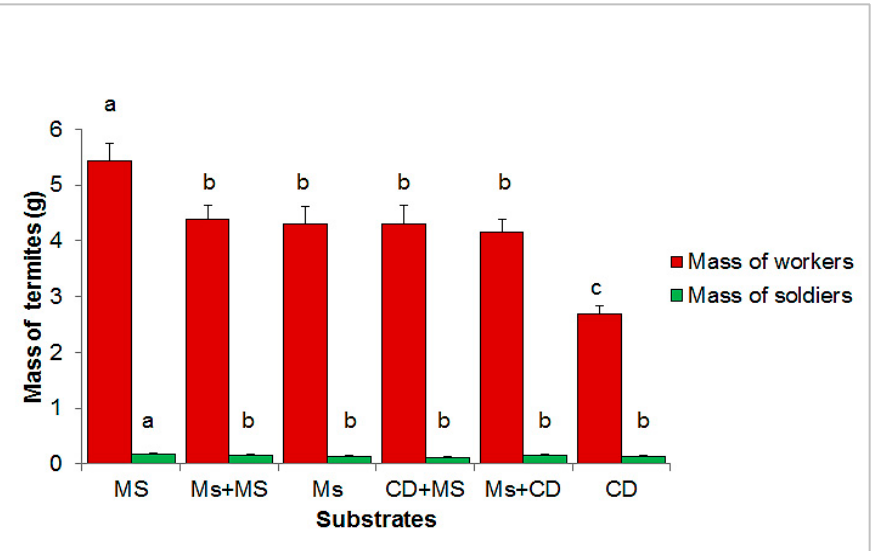
Figure 6. Average masses of soldiers and workers harvested per container according to substrates (MS = maize stems; Ms + Ms = maize cobs + maize stems; Ms = maize cobs; CD + MS = cow dung + maize stems; and Ms + CD = maize cobs + cow dung; CD = cow dung). Error bars represent standard errors. Histograms with the same letter are not significantly different at the 5% level. Means ± SE for soldiers: MS: 0.181 ± 0.012; Ms + MS: 0.146 ± 0.010; Ms: 0.143 ± 0.010; CD + MS: 0.119 ± 0.008; Ms + CD: 0.147 ± 0.010; and CD: 0.143 ±